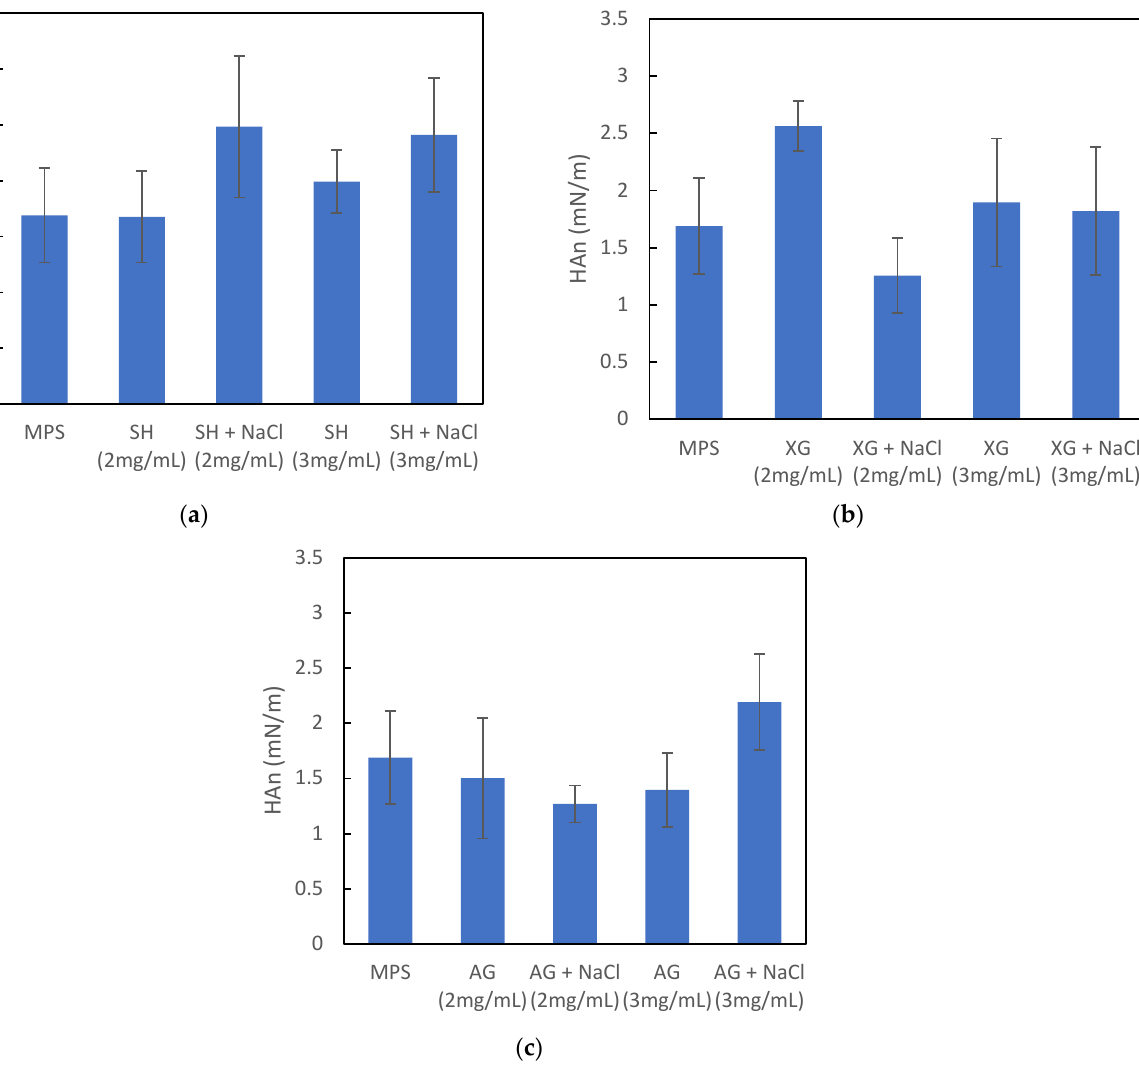
Figure 3. Normalized hysteresis area ( HAn ) of air –water or air–saline interface in the presence of MPS and VM: ( a ) SH , ( b ) XG , and ( c ) AG. Oscillation frequency f = 0.1 Hz. Error bars show the standard deviation ( n = 6).